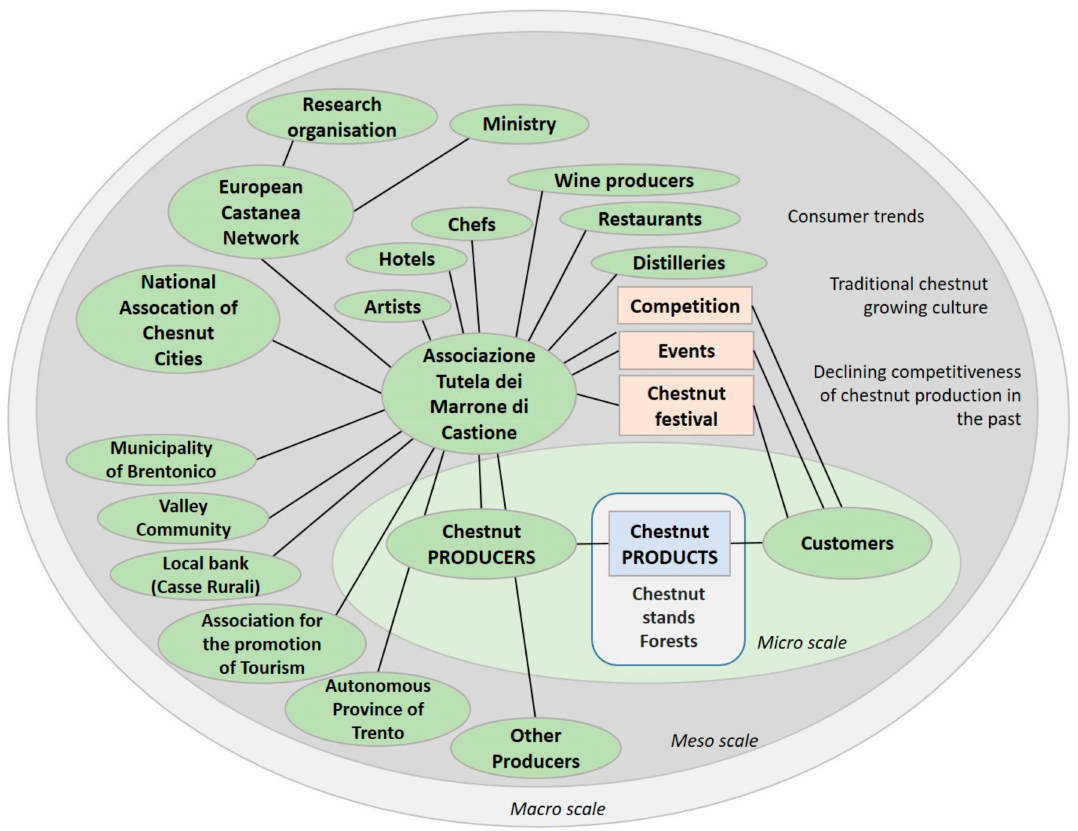
Figure 4. Actor network and context of the regional marketing initiative of “Castione” around